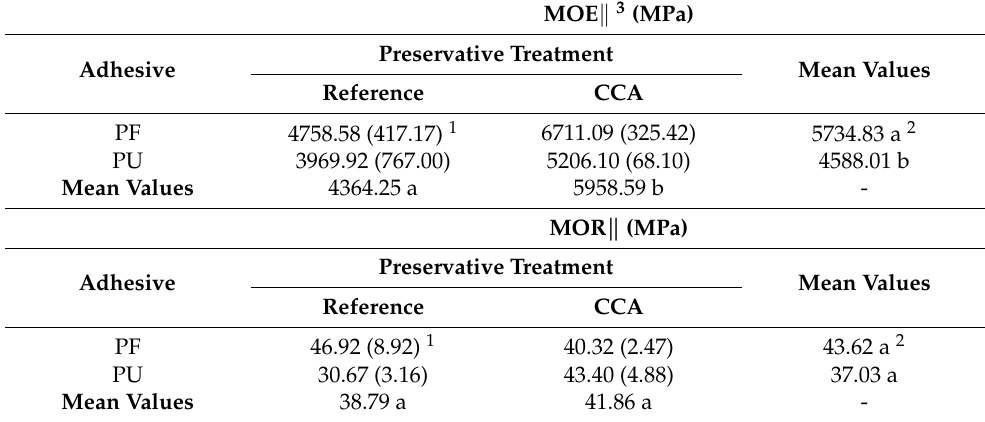
Table 8. Parallel static bending.